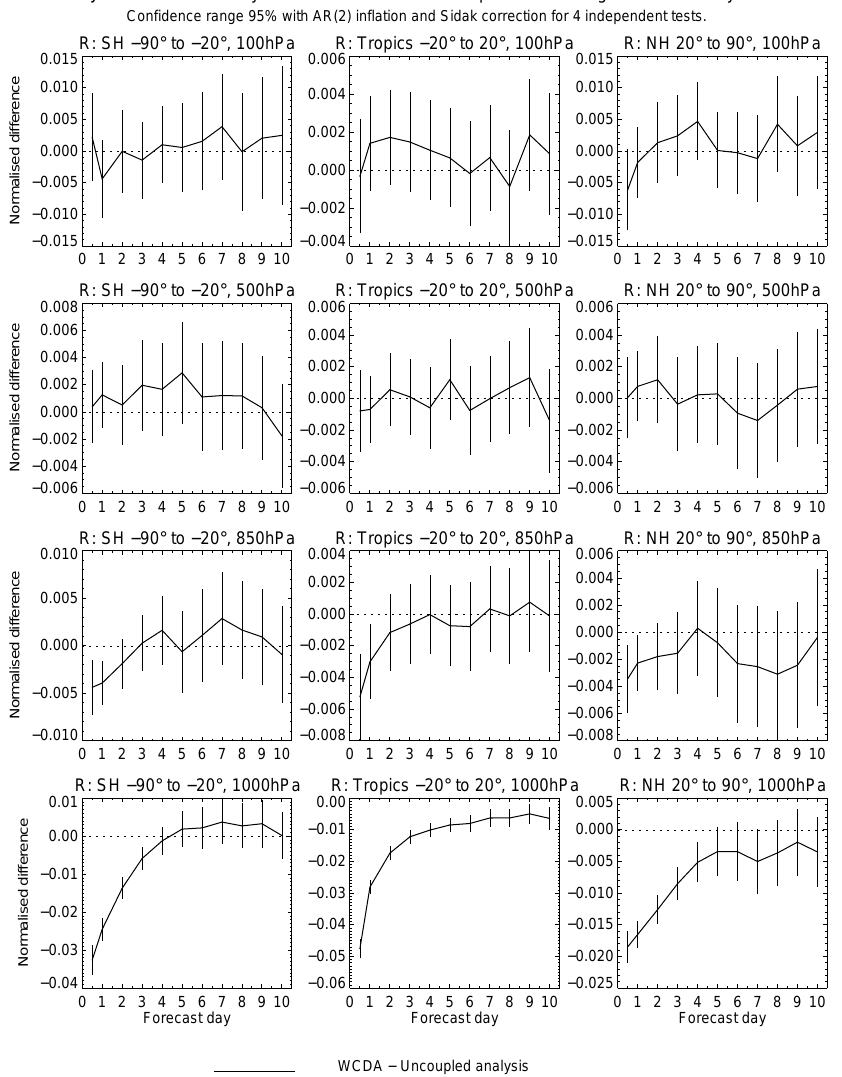
Figure A4. As in Figure A1 but for atmospheric relative humidity and stratified by level, 100 hPa ( top Figure A4. As Figure A1 but for atmospheric relative humidity and stratified by level, 100hPa (top row), 500hPa (second row), 850hPa (third row) and 1000hPa (bottom row). row ), 500 hPa ( second row ), 850 hPa ( third row ) and 1000 hPa ( bottom row